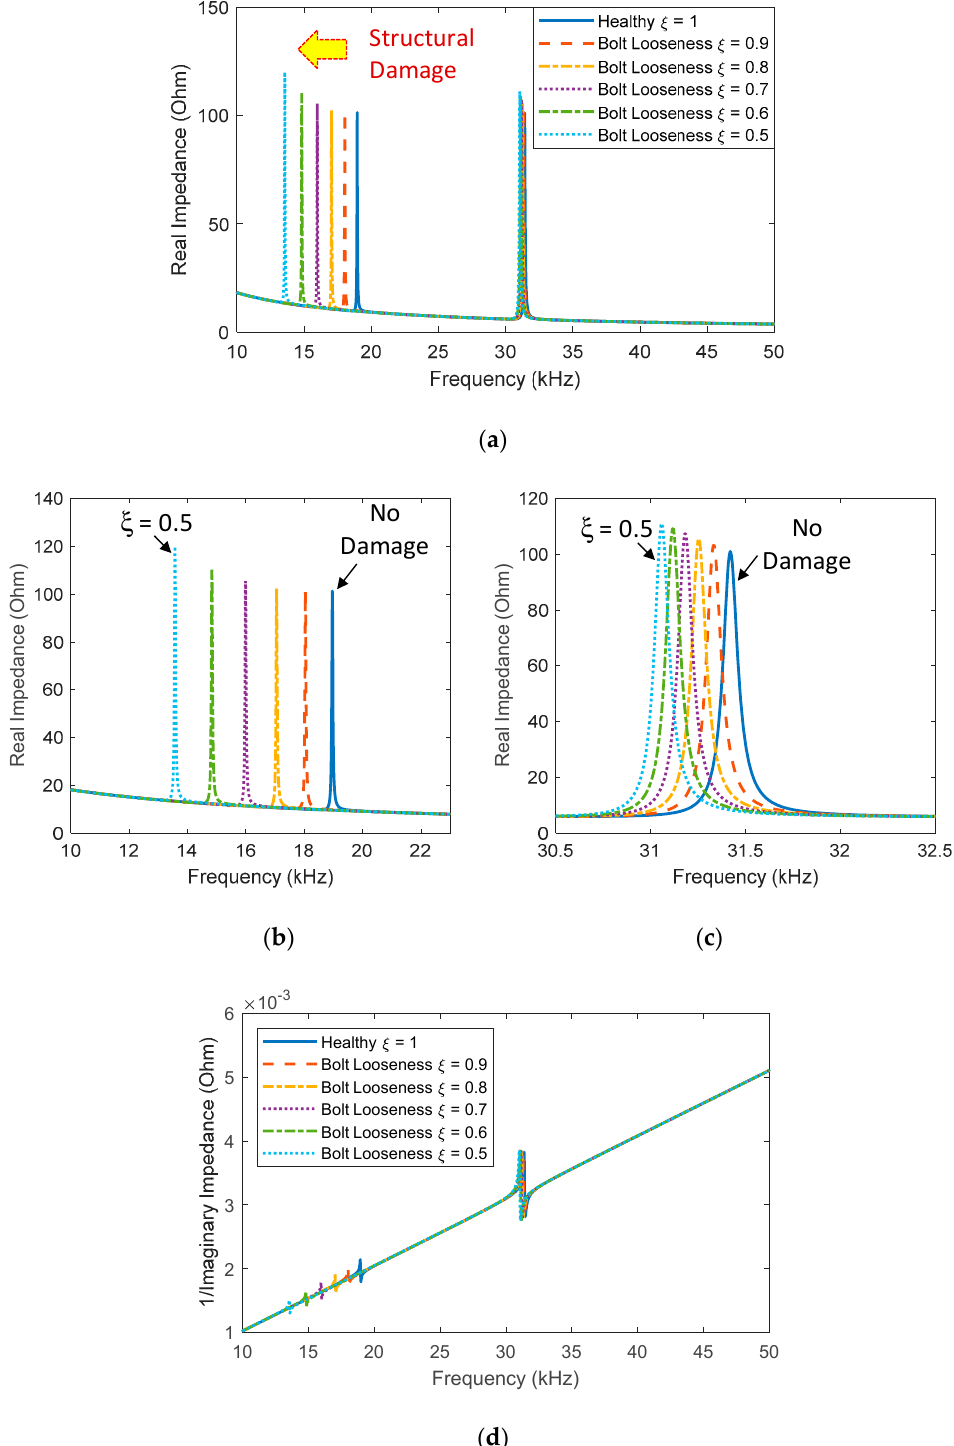
Figure 13. Analytical impedance signatures under the structural damage e ff ect: ( a ) real part in 10–50 kHz; ( b ) real part in 18.5–20 kHz; ( c ) real part in 30.5–32.5 kHz; ( d ) imaginary part in 10–50